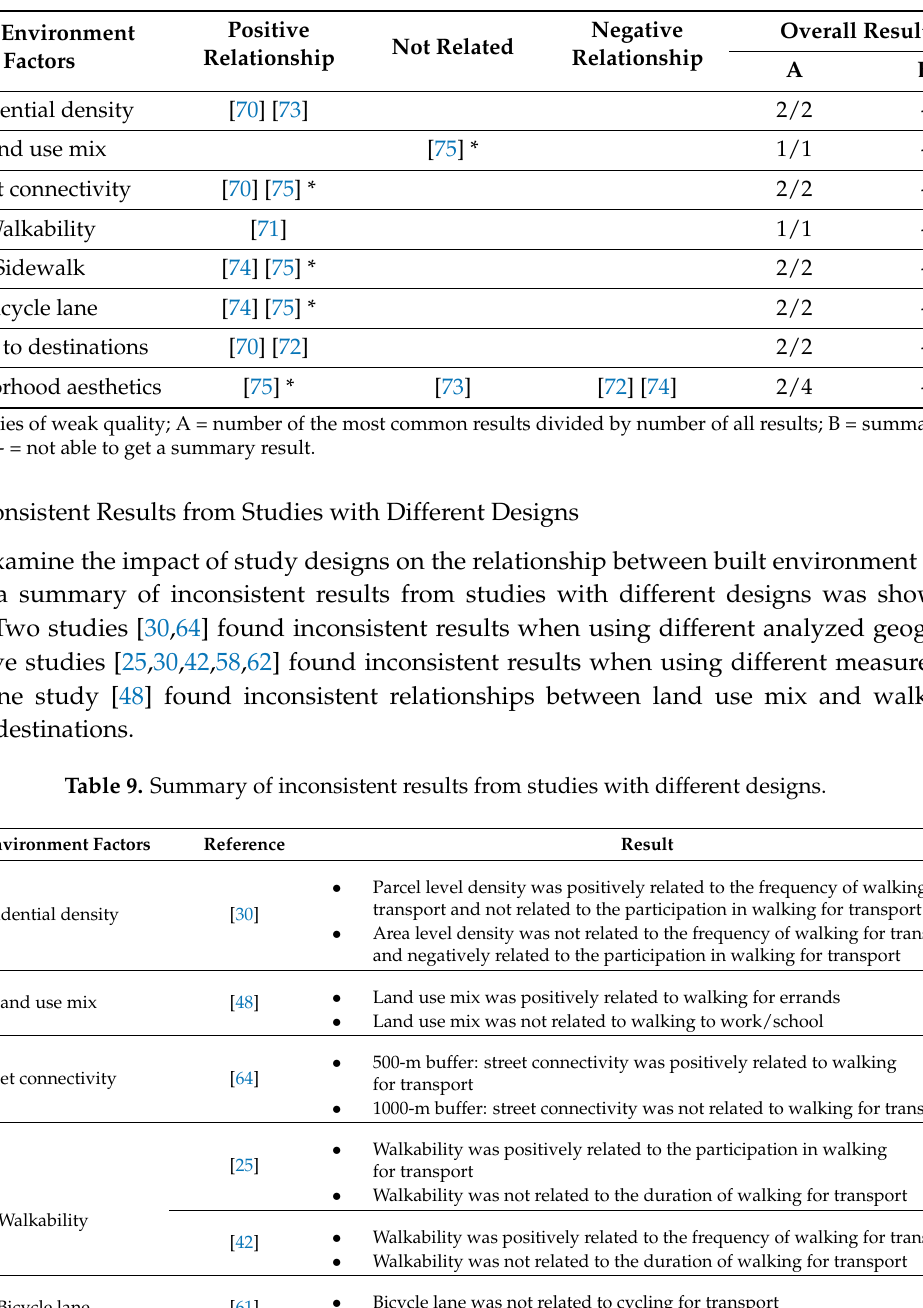
Table 8. Summary of relationships between built environment and general active transportation.